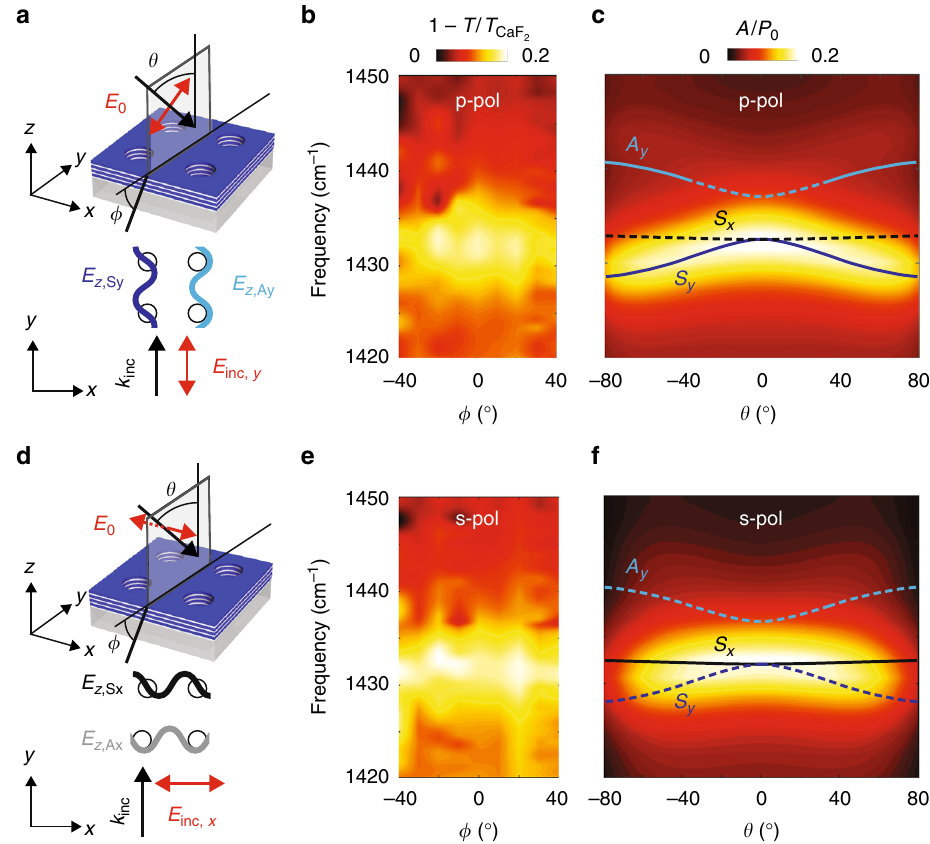
Fig. 4 Angle- and polarization-independent HPhP Bragg resonance in the h-BN polaritonic crystal. a , d Top: schematics of the angle-dependent transmission experiments for p- and s-polarization. Bottom: spatial distribution of the vertical electric fi eld of the Bloch modes in the vicinity of the resonance frequency. b , e Measured normalized extinction, 1 (cid:1) T = T , as a function of the stage rotation angle, ϕ , and frequency. c , f Calculated CaF 2 normalized absorption as a function of the incident angle, θ , and